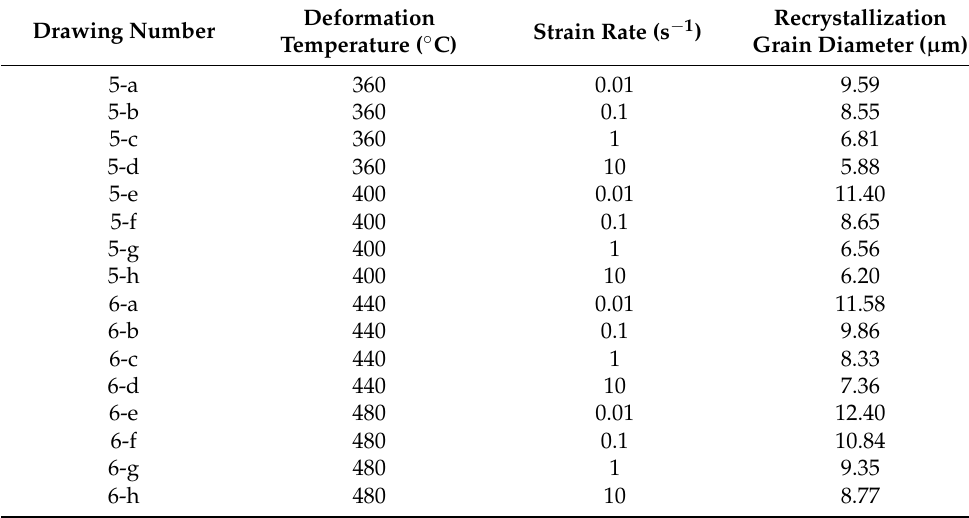
Table 3. Measured recrystallization grain size in the sample